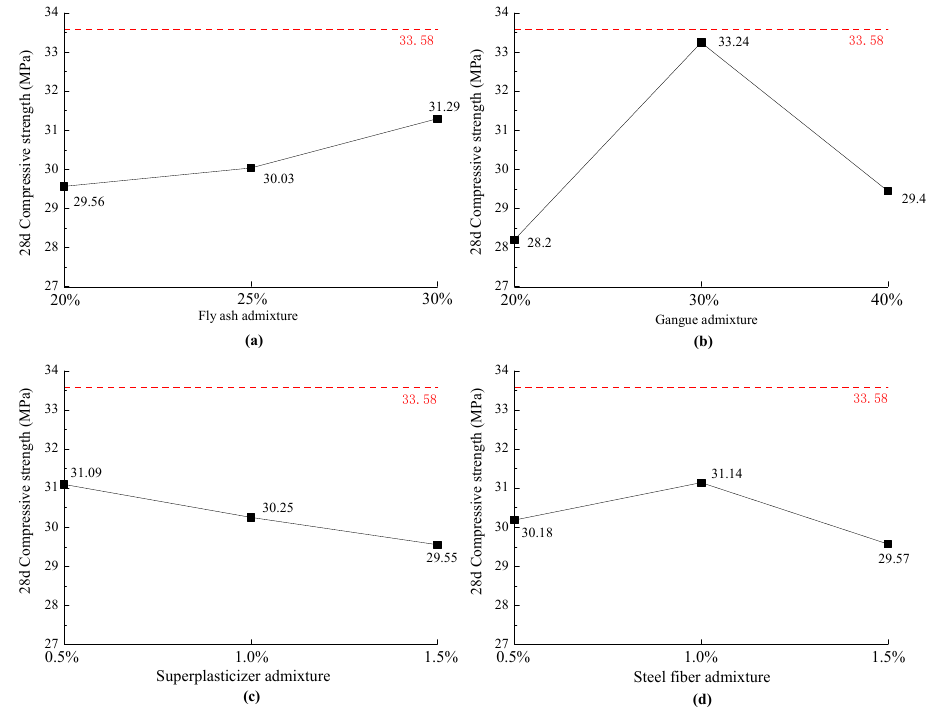
Figure 10. Influence of various factors on compressive strength of concrete. ( a ) The influence of fly ash on the compressive strength of concrete. ( b ) The influence of gangue on the compressive strength of concrete. ( c ) The influence of superplasticizer on the compressive strength of concrete. ( d ) The influence of steel fiber on the compressive strength of